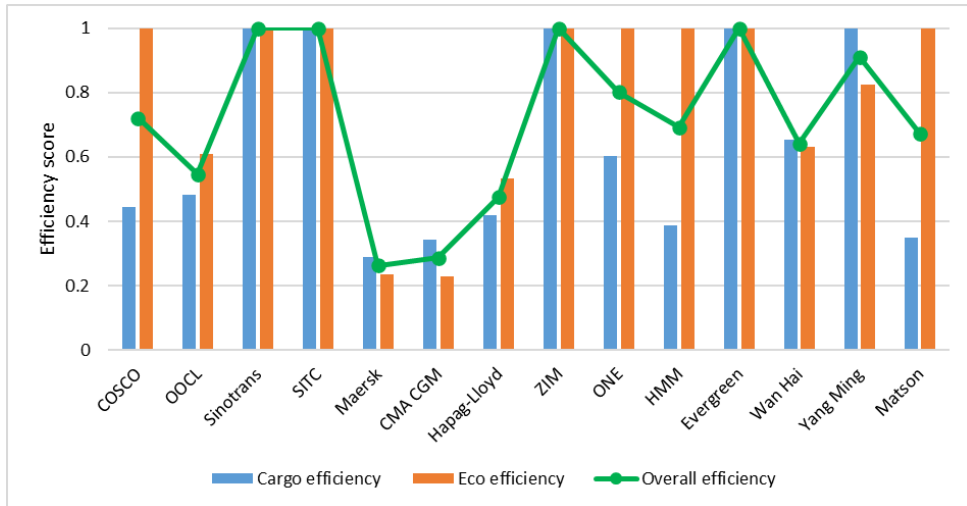
Figure 7. Comparison of the CSCs efficiency scores.